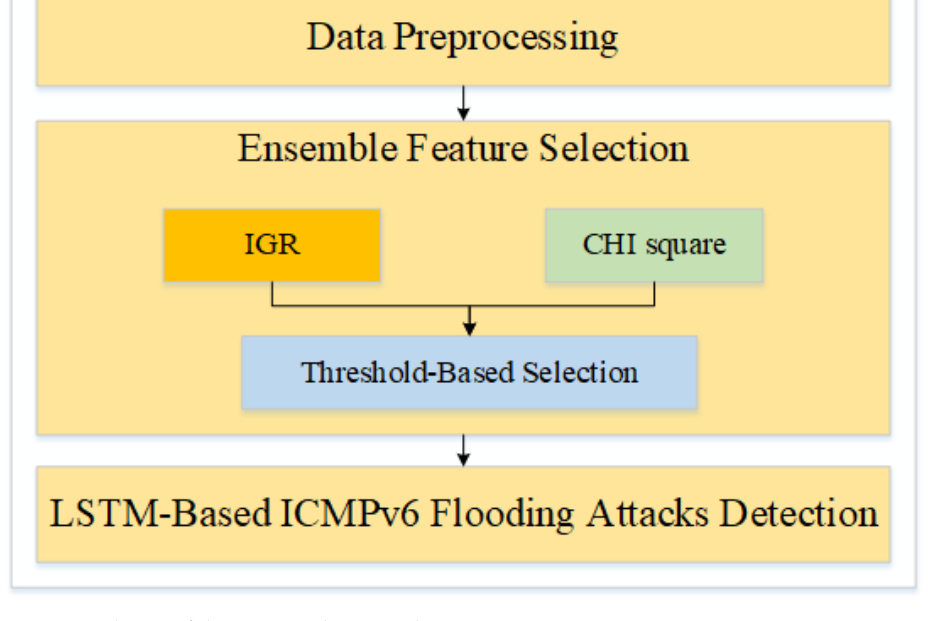
Figure 3. Phases of the proposed